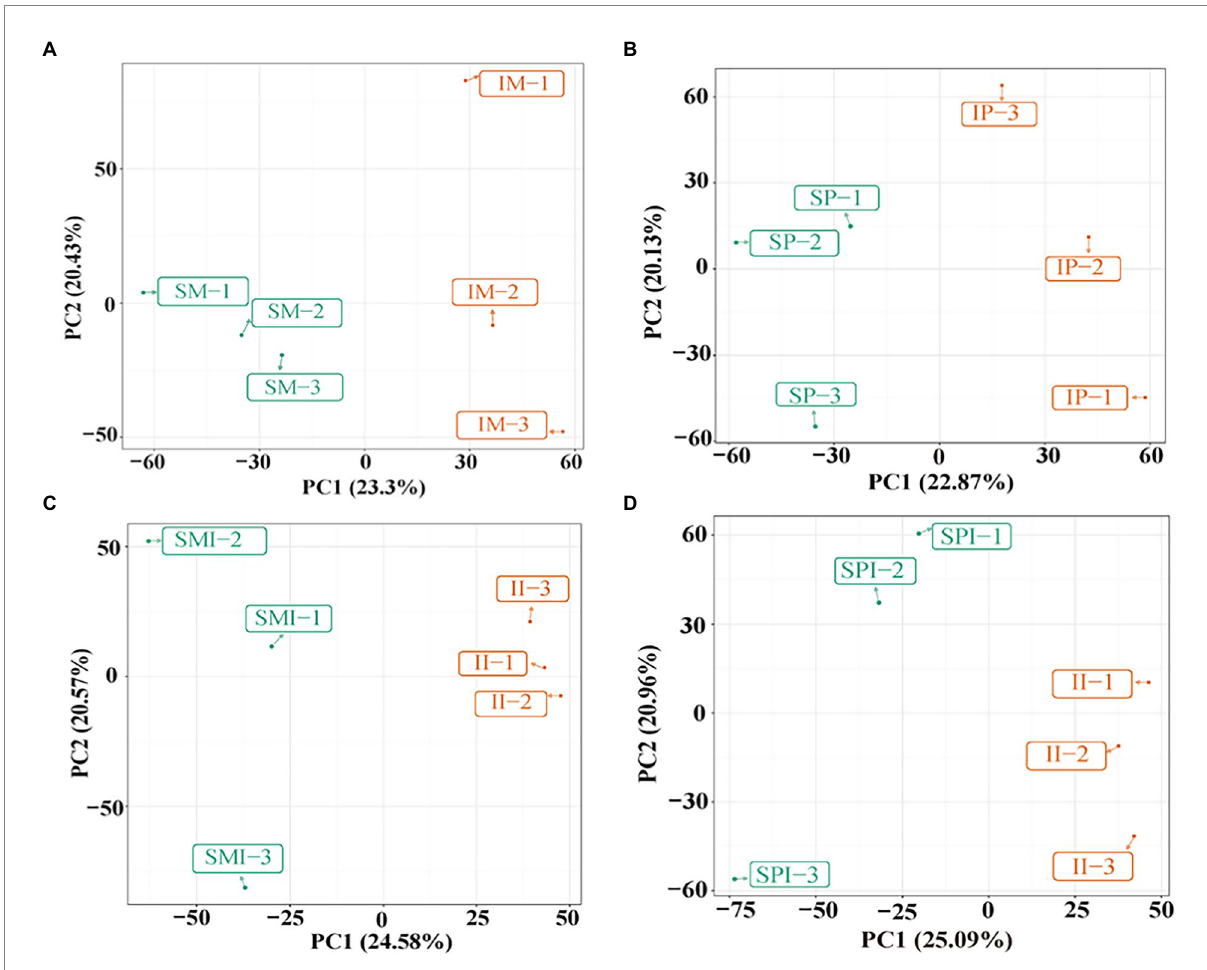
FIGURE 2 Principal component analysis (PCA) of maize and peanut root exudates under different planting patterns. (A) SM vs. IM, (B) SP vs. IP, (C) SMI vs. II, (D) SPI vs. II. SM: sole maize, IM: intercropped maize, SP: sole peanut, IP: intercropped peanut, SMI: the shared soil of sole maize, SPI: the shared soil of sole peanut, II: the shared soil of intercropped maize and